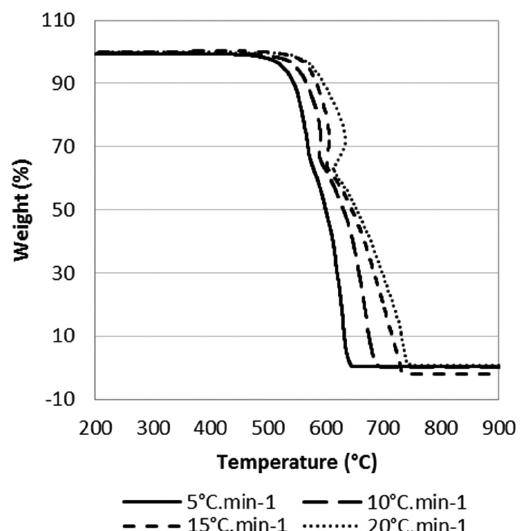
Figure 7. TGA curves of PEEK in Synthetic air atmosphere for the heating rates of 5 °C.min –1 ; 10 °C.min –1 ; 15 °C.min –1 and 20 °C.min –1